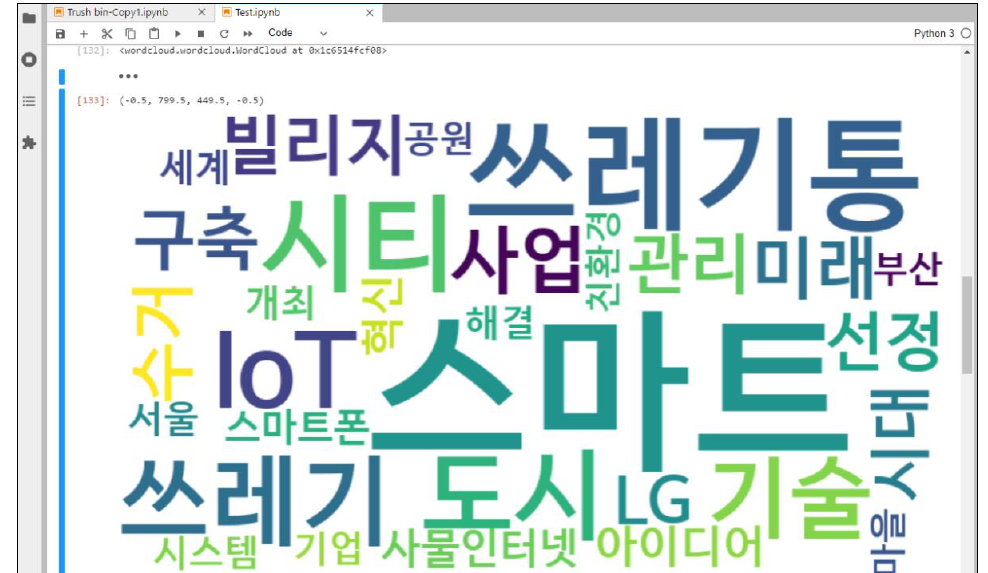
Figure A1. WordCloud based on “Smart Trash Bin.